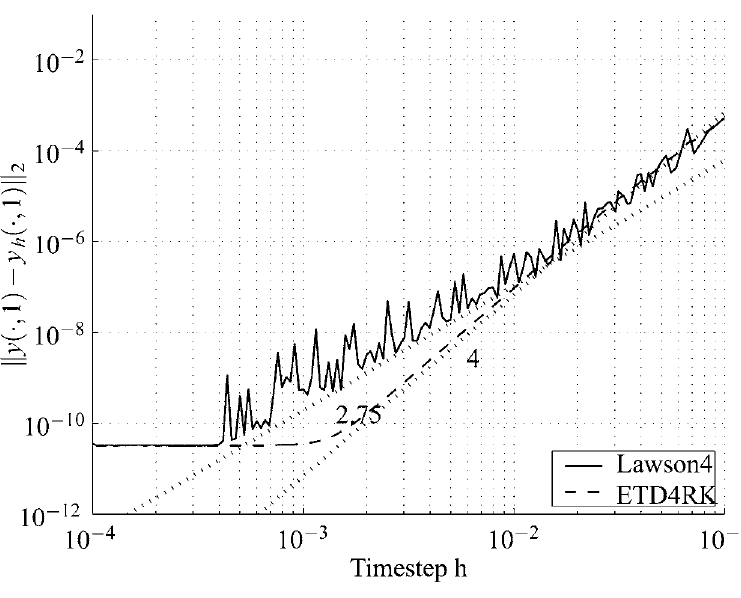
Figure 4. Global error when the potential has regularity